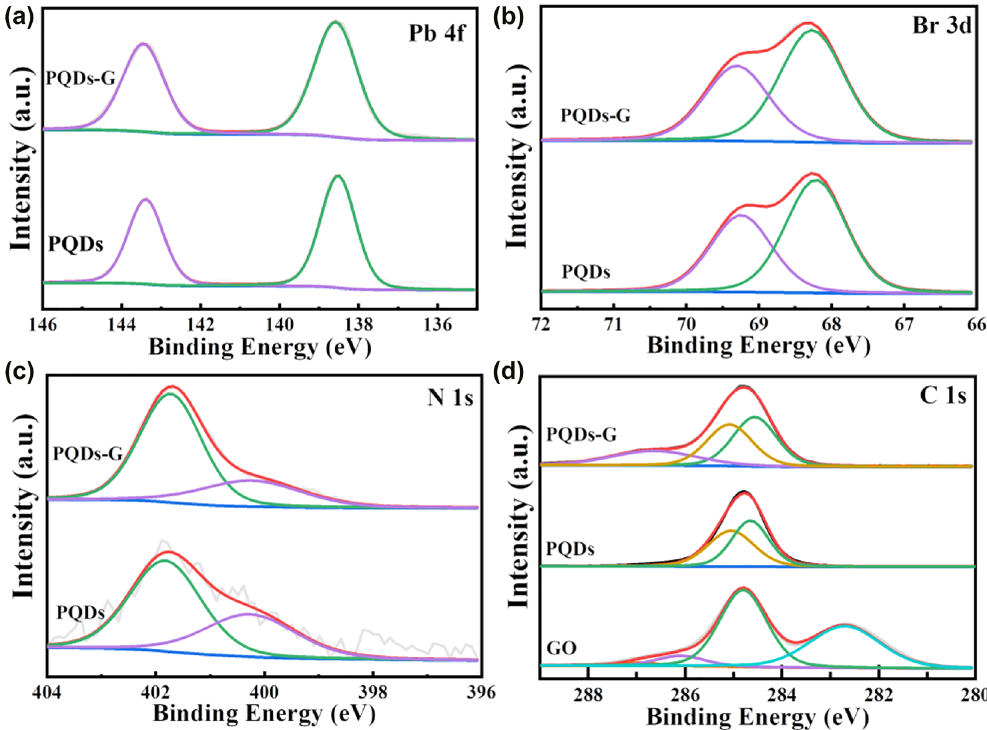
Figure 3: XPS spectrum of PQDs and PQDs-G for the Pb 4f (a), Br 3d (b) and N 1s (c) states. (d) C 1s spectrum of GO, PQDs and PQDs-G. of photons with composite structures, and then affects the photophysical properties of the